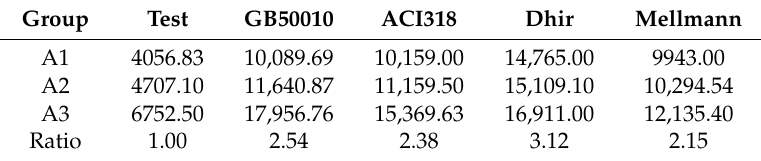
Table 8. Comparison of the test results and the results calculated from each formula.